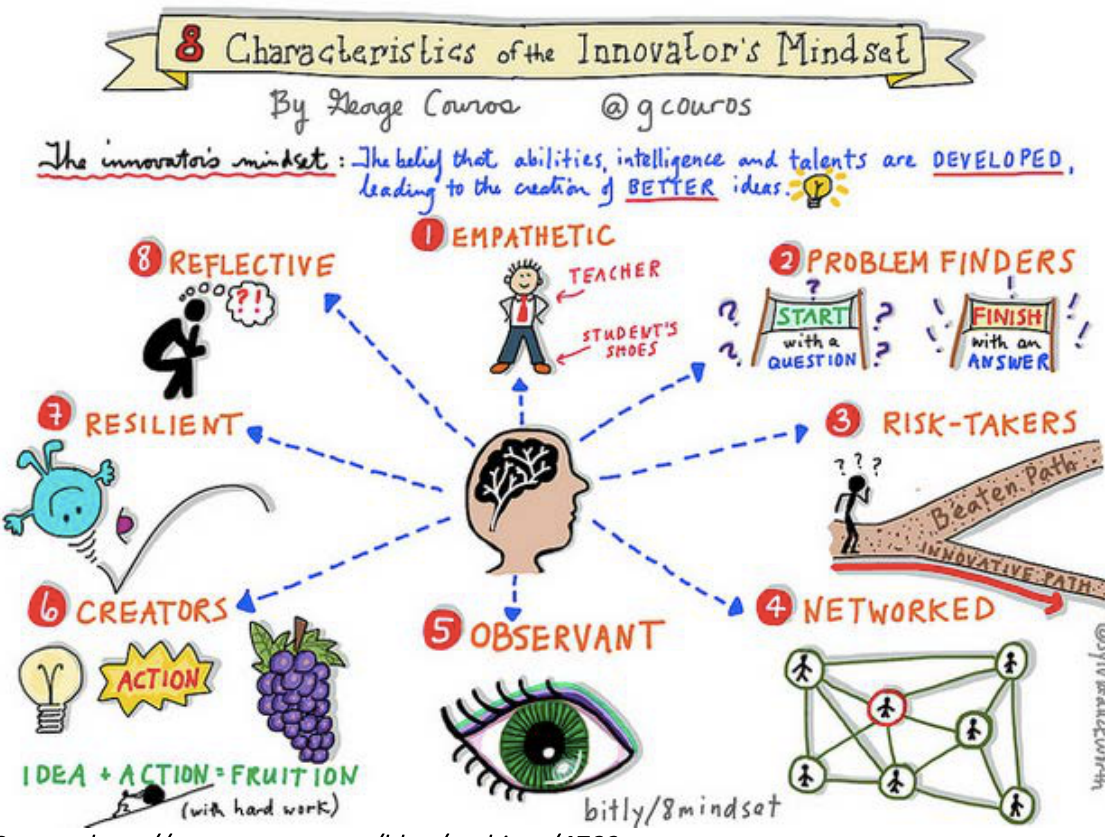
Figure 2. Eight characteristics of the Innovator’s